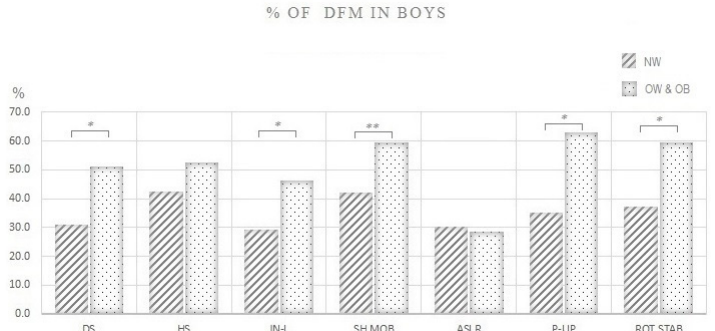
Figure 4. Proportion (%) of boys with normal weight and boys with overweight and obesity that performed dysfunctional movement (DFM) in each FMS test. Note: % OF DFM IN BOYS: Proportion (%) of boys that performed dysfunctional movement; NW: Boys with normal weight; OW & OB: Boys with overweight and obesity; DS: Deep squat; HS: Hurdle step; IN-L: Inline lunge; ASLR: Active straight leg raise; SHO MOB: Shoulder mobility; P-UP: Trunk stability push-up; ROT STAB: Rotary stability. * p < 0.0001, ** p =